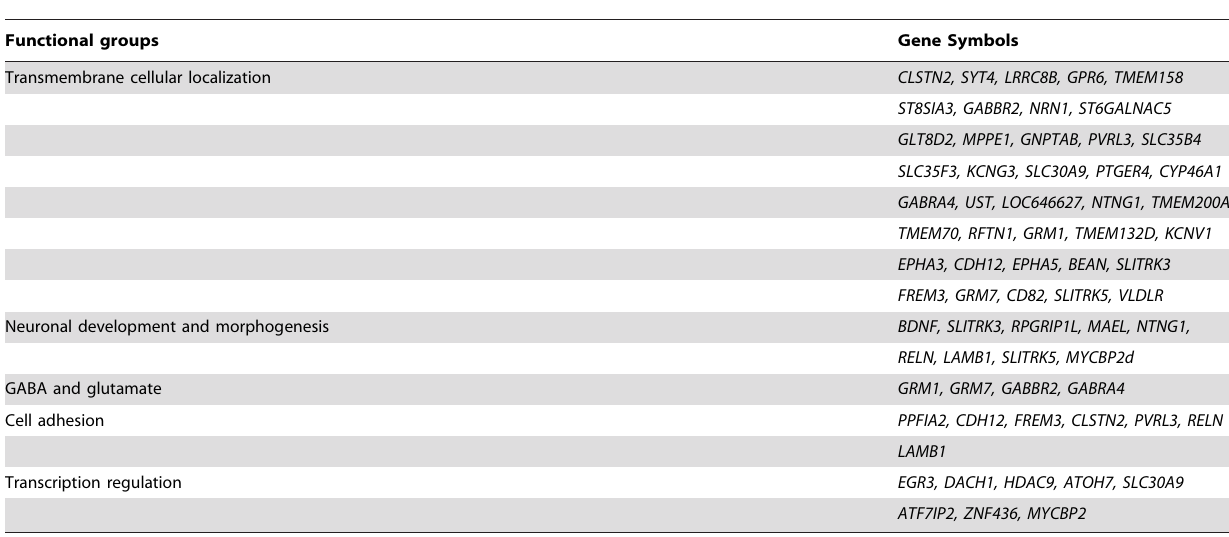
Table 2. Functional groups of 88 gene in module # 35 .